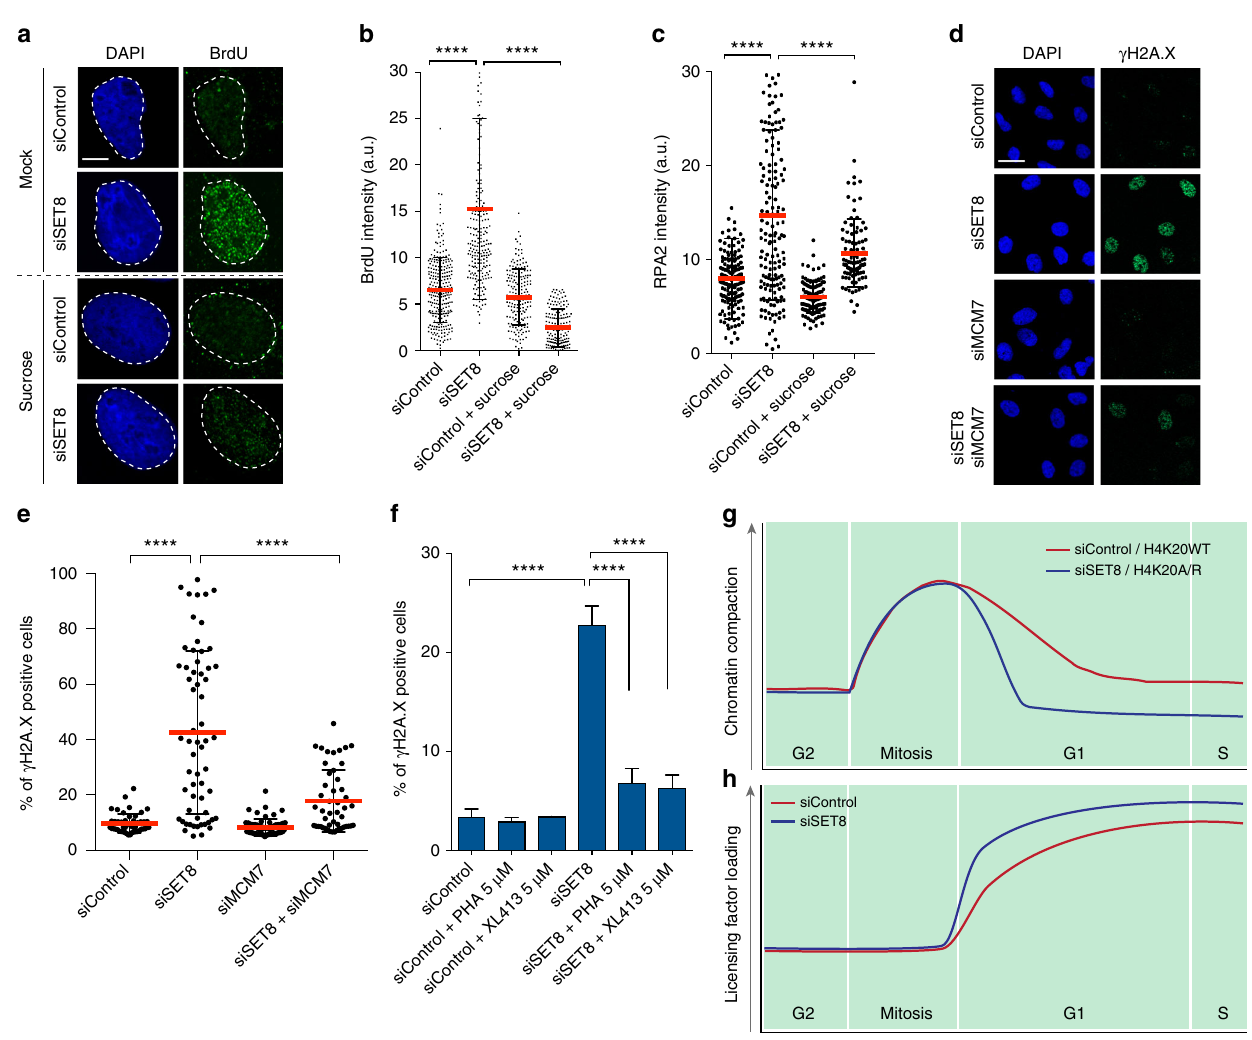
Fig. 4 Chromatin-mediated suppression of the MCM2-7 complex promotes genome integrity. a U2OS cells synchronized by double thymidine block were transfected with Control and SET8 siRNA. Cells were released into BrdU-containing medium from G1/S boundary and were mock or sucrose treated at 12h post G1/S release. Cells were then fi xed at 15h post G1/S release and were immunostained with DAPI and γ H2A.X antibody (Bar, 10 µ m). b Scatter plot showing the quanti fi cation of BrdU intensity ( a ). Mean±SD is indicated by red lines. n >230, **** p <0.0001 (ANOVA). c U2OS cells were synchronized, siRNA transfected, treated with sucrose, and fi xed as in a . Samples were immunostained with an RPA2 antibody after pre-extraction. Scatter plot showing the quanti fi cation of RPA2 intensity. Mean ±SD is indicated by red lines. n >150, **** p <0.0001 (ANOVA). d U2OS cells were transfected with siMCM7 and synchronized with double thymidine block. SET8 was depleted 6h before G1/S release. Cells were fi xed at 15h post release and processed for immuno fl uorescence staining with DAPI and γ H2A.X antibody (Bar, 30 µ m). e Scatter plot showing the quanti fi cation of γ H2A.X intensity from cells in d . Mean±SD is indicated by red lines. n > 50, **** p < 0.0001 (ANOVA). f U2OS cells were synchronized and transfected as in a . DDKi inhibitors (PHA- 767491 and XL413) were added at 11h post release from G1/S boundary. Cells were then collected at 15h post release and processed for FACS staining with PI and γ H2A.X antibody. Bars representing the percentage of γ H2A.X-positive cells in the indicated samples (average±SD of three independent experiments). **** p <0.0001 (unpaired t test). n >20,000 in each experiment. g Illustrative plot details the dynamics of chromatin compaction/decompaction over different phases of cell cycle. Loss of SET8 and H4K20me leads to a notable reduction in chromatin compaction status in cells exiting mitosis. h Illustrative plot